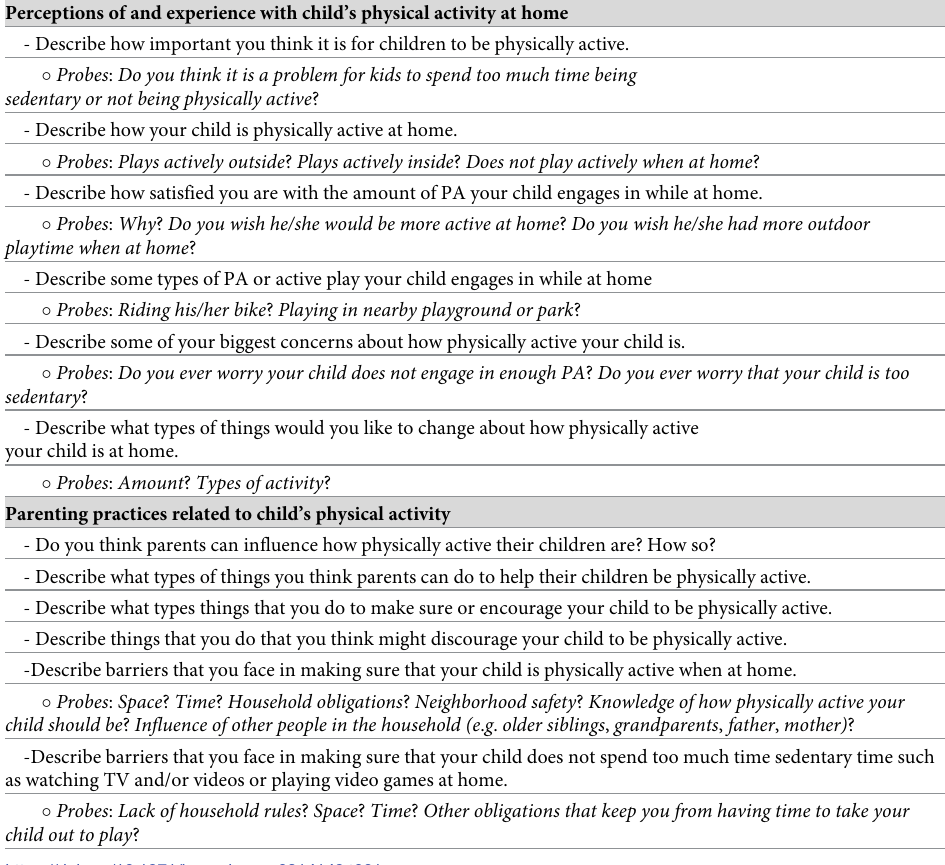
Table 1. Sample of questions and prompts used in focus groups with